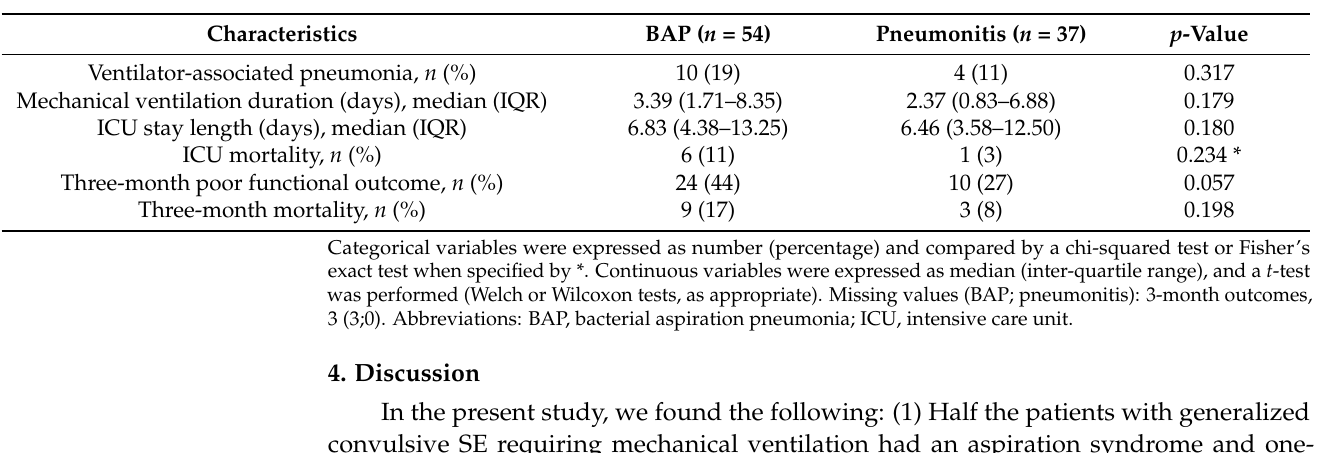
Table 4. Comparison of patients’ outcomes according to the diagnosis of BAP or